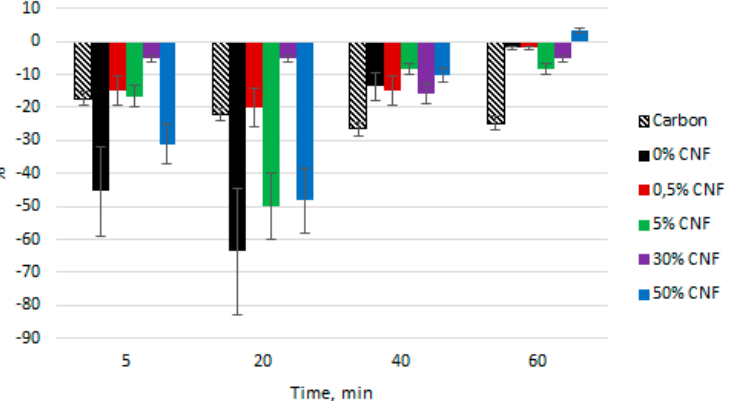
Figure 4. The change in time of the optical density of blood plasma upon contact of blood with sorbents in vitro at a wavelength of 540 nm.